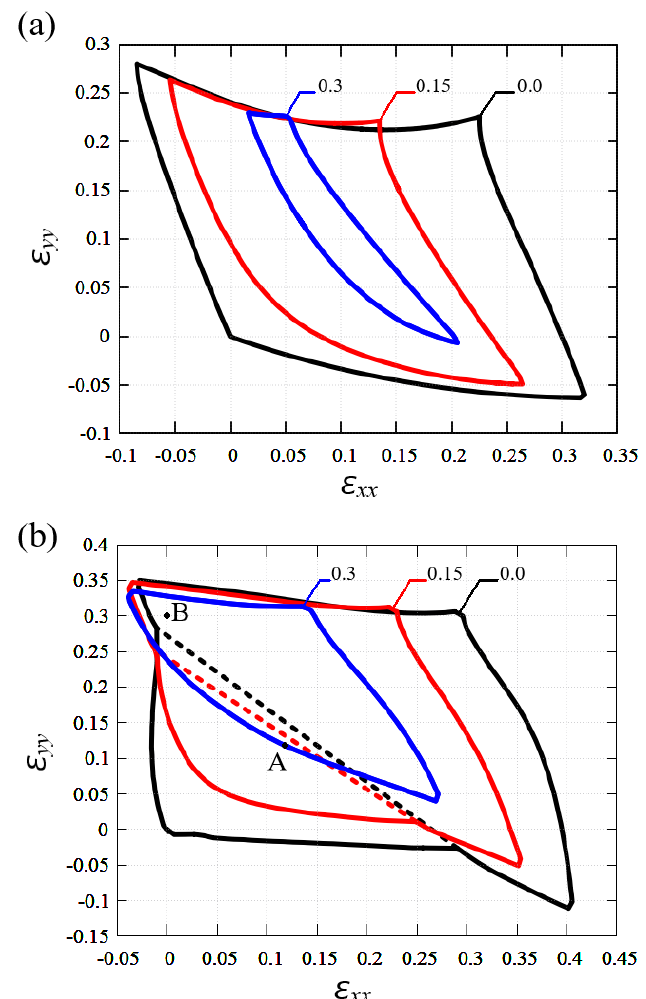
Figure 7. The effect of shear strain on the stability region of planar graphene ( a ); and stanene ( b ). Results for ε xy = 0.0, 0.15 and 0.3 are plotted by the black, red, and blue lines, respectively. Panel ( b ) also shows the points A and B chosen for the analysis of the stanene